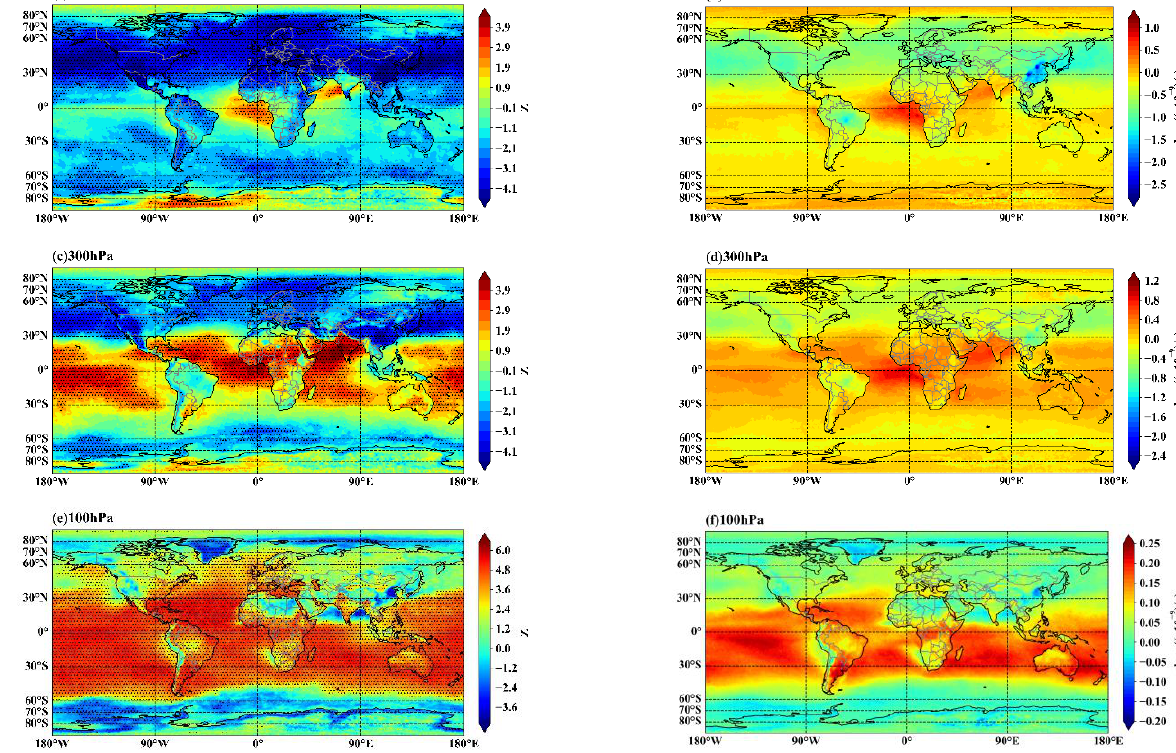
Figure 12. Spatial trend of Global CO concentration MK in the middle and upper troposphere from 2003 to 2021. ( a , b ) 500 hPa; ( c , d ) 300 hPa; ( e , f ) 100 hPa. Note: The black dot indicates that the region has passed the 95% significance test.